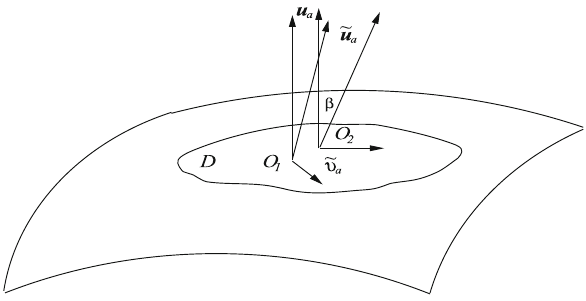
Fig. 1 Observers( O 1 , O 2 )insideabulk-flow ( D ),withpeculiarveloc- ity ˜ v a relative to the Hubble expansion. The 4-velocities u a and ˜ u a , with a hyperbolic “tilt” angle ( β ) between them, define the reference